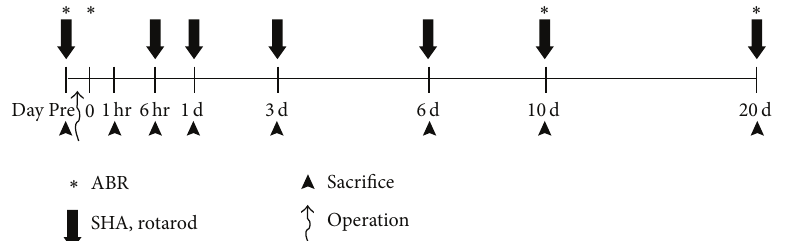
Figure 1: Schematic timeline of the experiments. Auditory brainstem response (ABR) thresholds were obtained before and immediately after surgery, at 10 and 20 days after surgery. The rotatory chair test (sinusoidal harmonic acceleration, SHA) was conducted prior to and at 6 hours and 1, 3, 6, 10, and 20 days after surgery. The assessment of peripheral vestibular organ hair cells was conducted 20 days after surgery. Changes in c-Fos immunoreactivity at the vestibular nucleus were evaluated at 1 and 6 hours and at 1, 3, 6, 10, and 20 days after